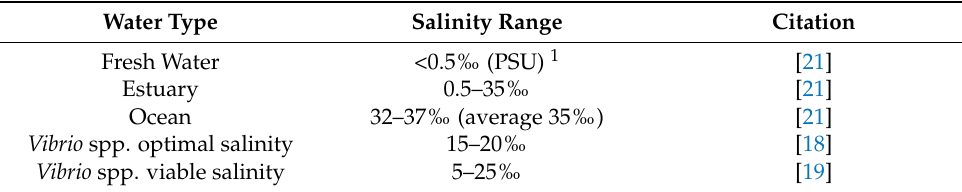
Table 1. Salinity range for Vibrio spp. and potential habitat water